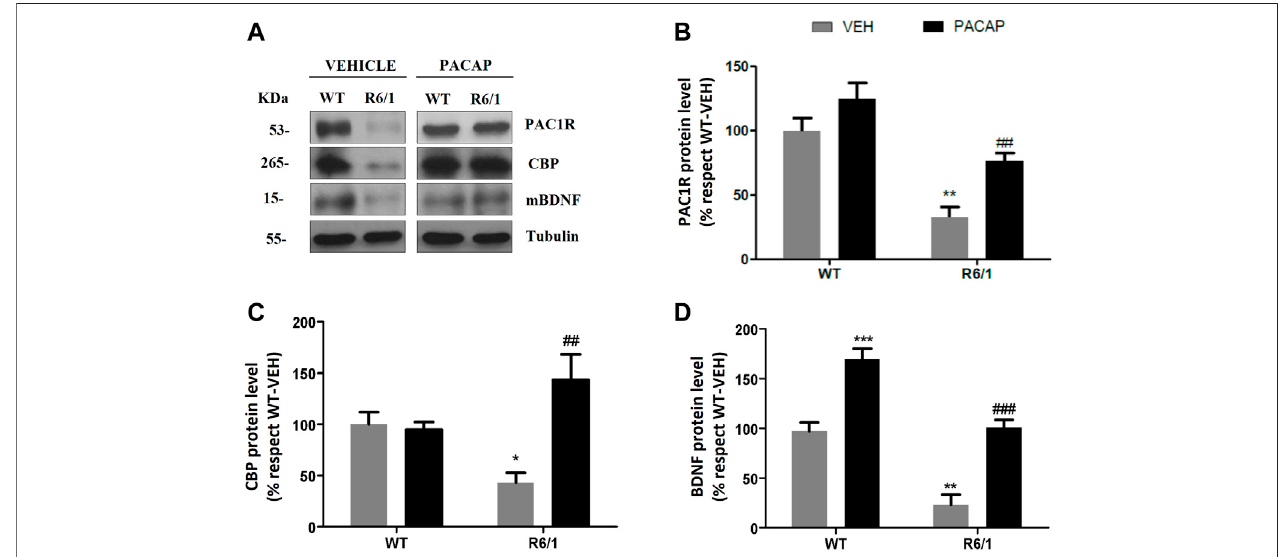
FIGURE 11 | PACAP administration increases PAC1R, CBP and BDNF protein levels in the striatum of R6/1 mice. WT and R6/1 mice were daily intranasally administrated at 18 weeks of age with vehicle (VEH) or PACAP (30 μ g/kg/day) for 7 days. Then, protein extracts from the striatum of all groups were subjected to Western blot for the immunodetection of PAC1R, CBP, and BDNF. (A) Representative immunoblots are shown. Quanti fi cation of (B) PAC1R, (C) CBP and (D) mBDNF wasperformed.Results(mean ± SEM; n (cid:1) 7)werenormalizedtotheloadingcontroltubulinandareexpressedasapercentagerespecttoVEH-WTmice.Datawere analyzedbytwo-way ANOVA followed byBonferroniaspost-hoc test.* p < 0.05,** p < 0.01 and*** p < 0.001ascompared toVEH-WTmiceand ## p < 0.01and### p < 0.001 as compared to VEH-R6/1 mice.